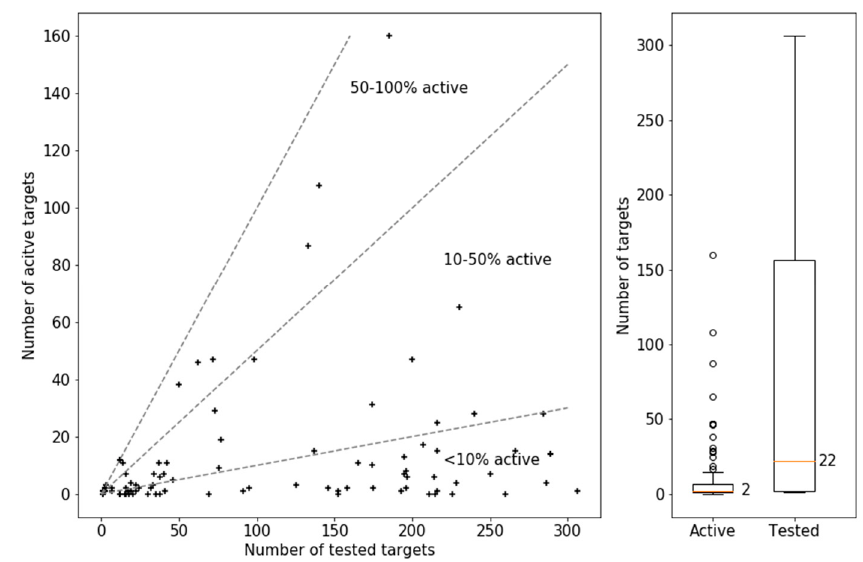
Figure 2. Activity annotations of MTLs in PubChem. The scatter-plot on the left compares the number of targets against which MTLs were tested (tested targets) and active (active targets). Each data point represents an MTL. Dashed lines mark similar ratios of active over tested targets. The boxplots on the right report the distributions of the number of tested targets (corresponding to test frequency) and active targets per MTL. The reported median is represented by an orange vertical line. The lower and upper boundaries of the boxes indicate the lower and upper quartile, respectively. The length of the whiskers corresponds to 1.5-fold of the interquartile range. Circles above or below the whiskers represent statistical outliers.